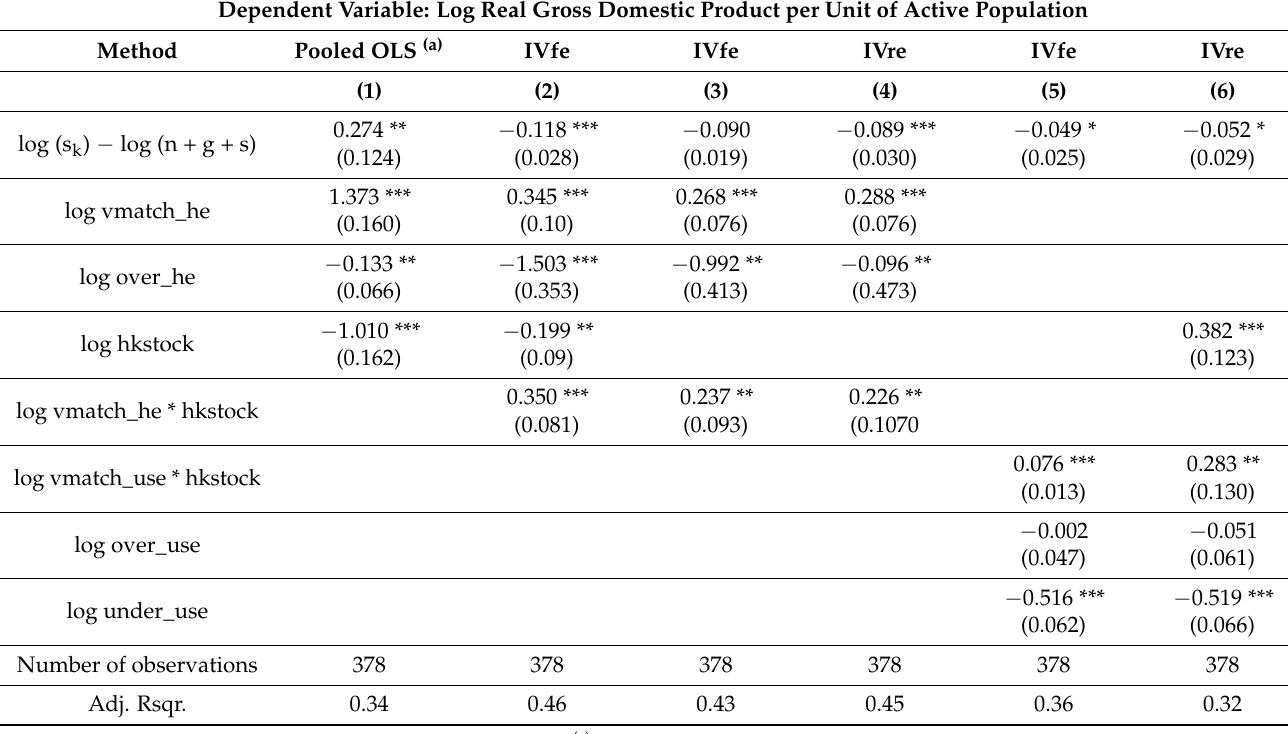
Table 5. Robustness checks: introduction of the human capital stock in the